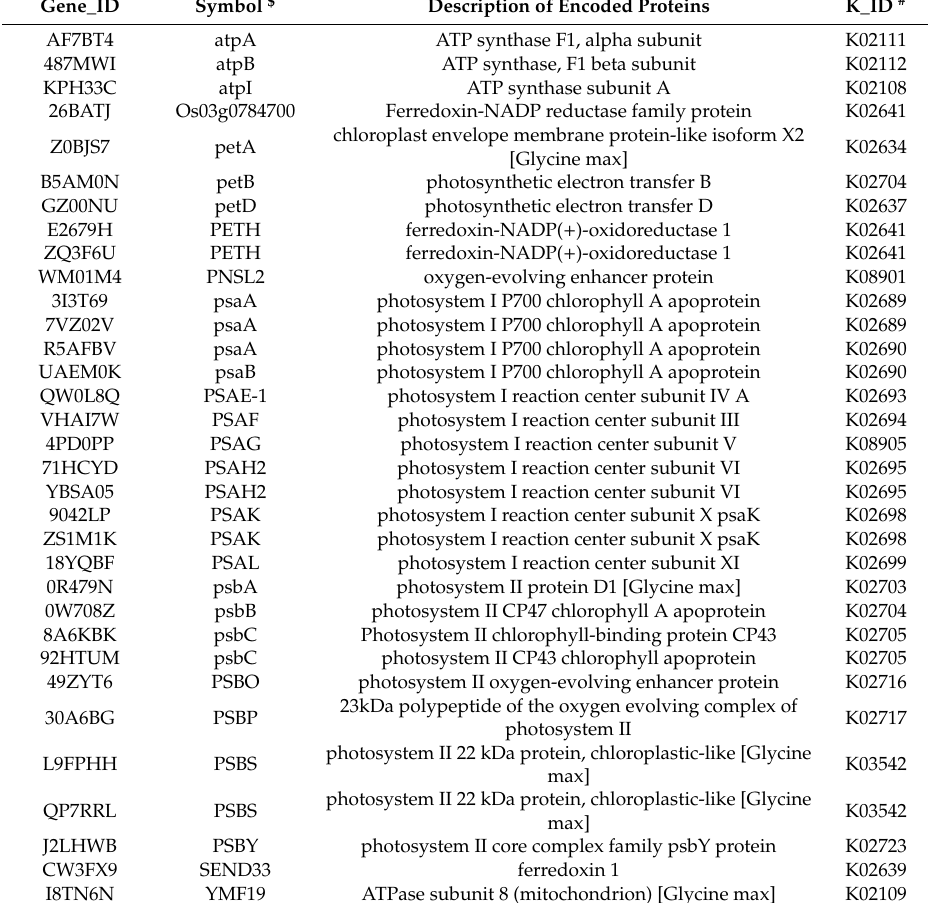
Table 4. The shade stress-induced DEGs and annotations in photosynthesis